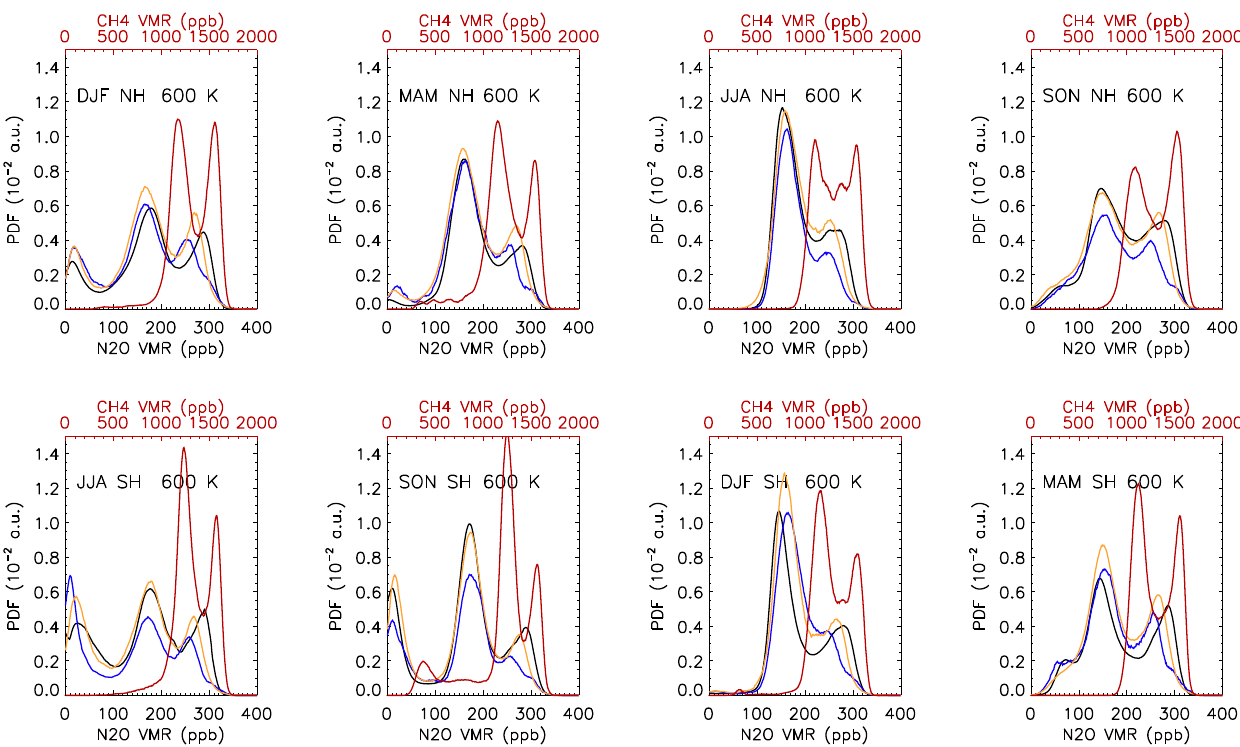
Fig. 2. Multiannual mean seasonal mean probability distribution functions of N 2 O (bottom x -axis)/CH 4 (top x -axis) VMR concentrations for MLS (black), MIPAS (blue), SMR (yellow), and HALOE (red) at 600K ( ∼ 30hPa) in the NH (upper row) and SH (lower row). Comparable seasons in the two hemispheres are lined up. The PDFs have been averaged over all of the years available from each sensor.